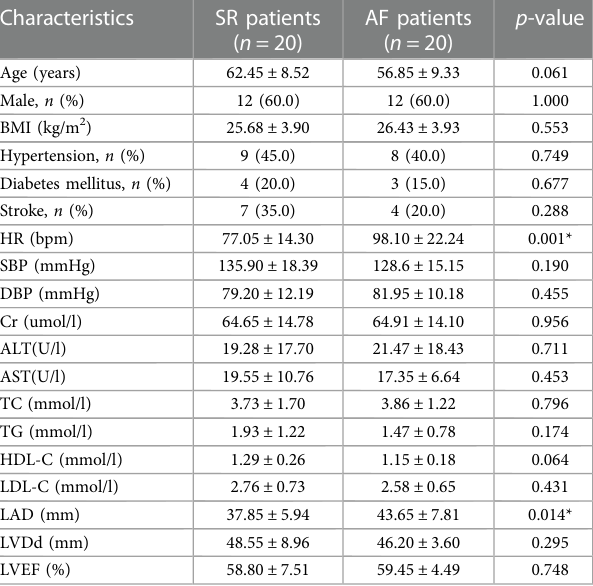
TABLE 5 Comparison of clinical characteristics between the two groups.